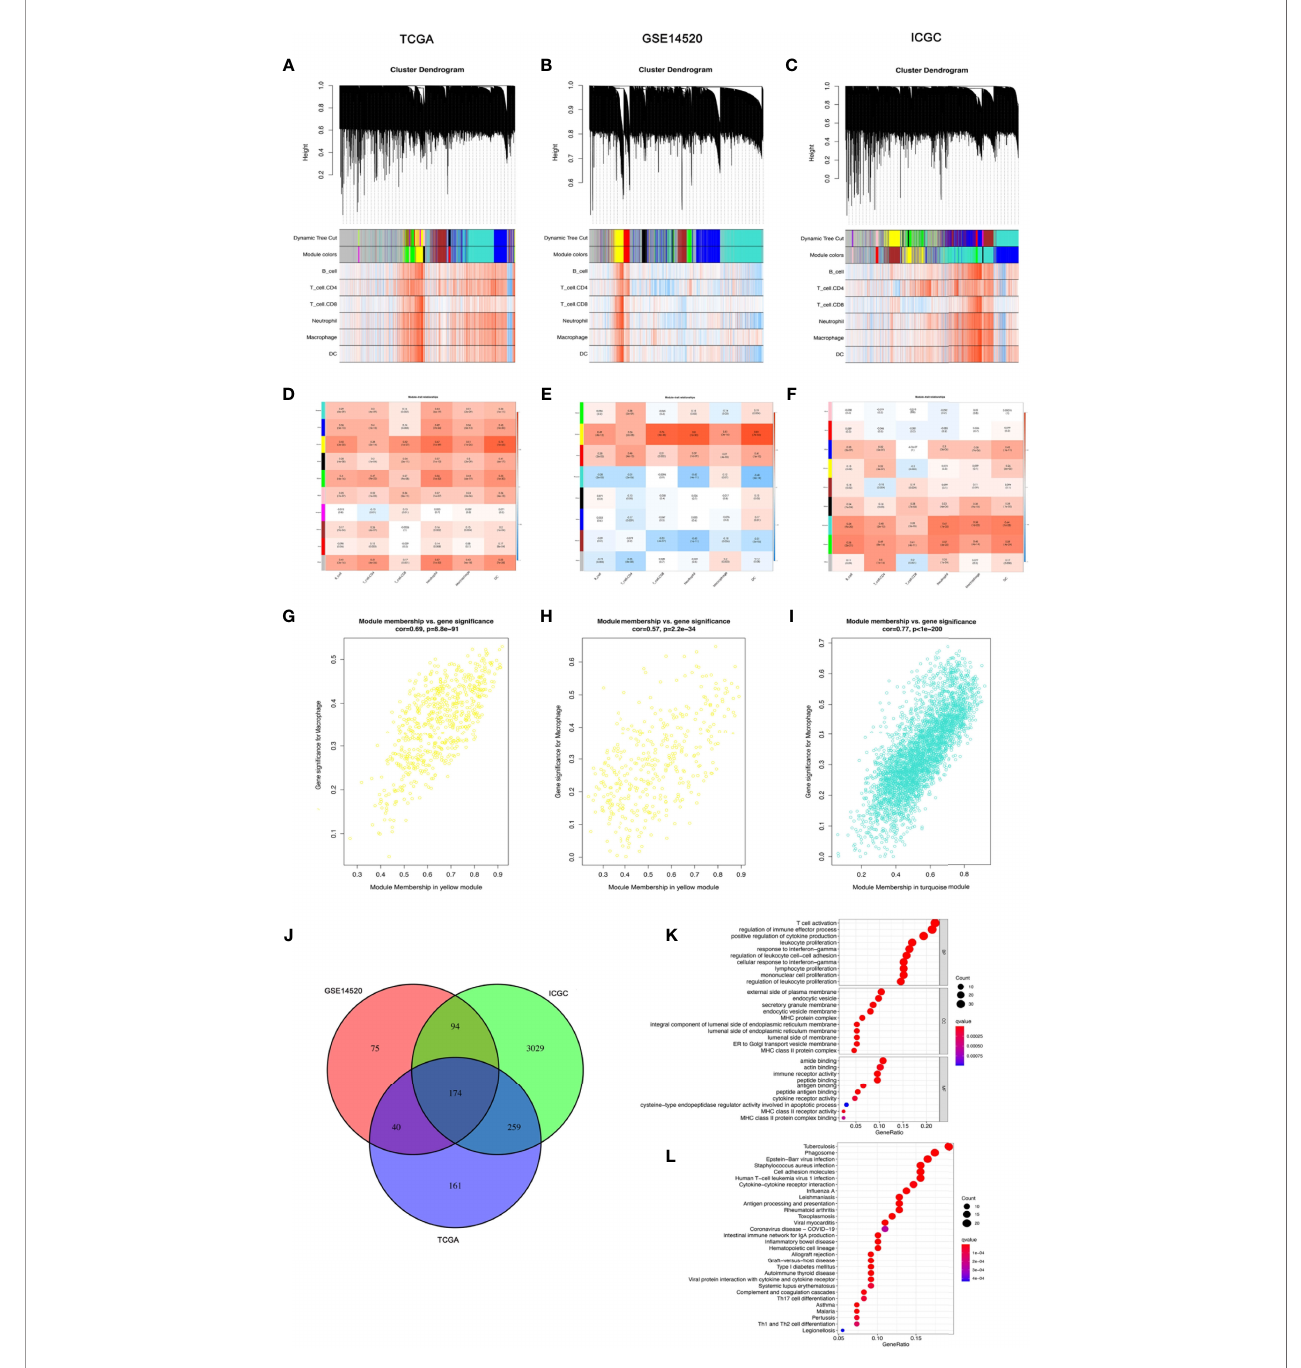
FIGURE 2 | The coexpression network established using weighted gene coexpression network analysis methods based on the (A) LIHC RNA-seq pro fi les from the TCGA-LIHC database, (B) GSE14520 dataset, and (C) the International Cancer Genome Consortium portal database. Heatmap demonstrating the correlation between module eigengenes and macrophages in the (D) TCGA-LIHC dataset, (E) GSE14520 dataset, and (F) International Cancer Genome Consortium portal dataset. (G) The yellow module had the strongest correlation with macrophage cell proportions in the TCGA-LIHC dataset (Cor = 0.69, P = 8.8e − 91). (H) The yellow module had the strongest correlation with macrophage cell proportions in the GSE14520 cohort (Cor = 0.57, P = 2.2e − 34). (I) The turquoise module had the strongest correlation with macrophage cell proportions in the ICGC (Cor = 0.77, P < 1e − 200). (J) Venn diagram displaying the macrophage-related selected intersection genes from different datasets. (K, L) Gene ontology (GO) and Kyoto Encyclopedia of Genes and Genomes (KEGG) analyses of macrophage-related intersecting